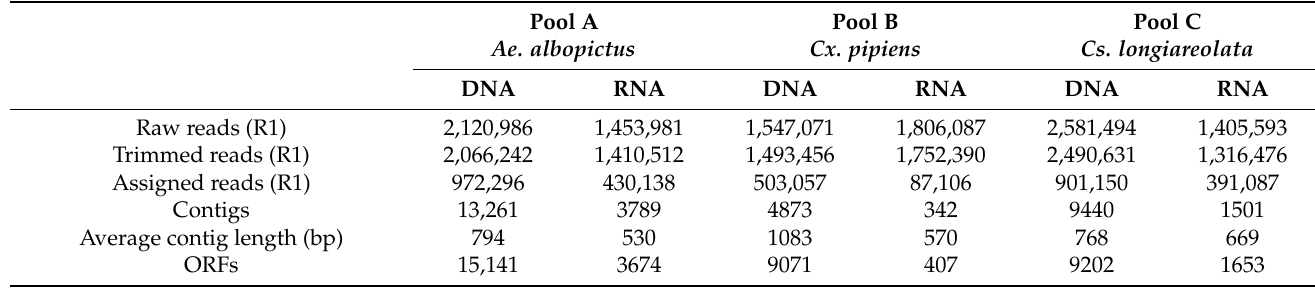
Table 2. Virome dataset statistics.